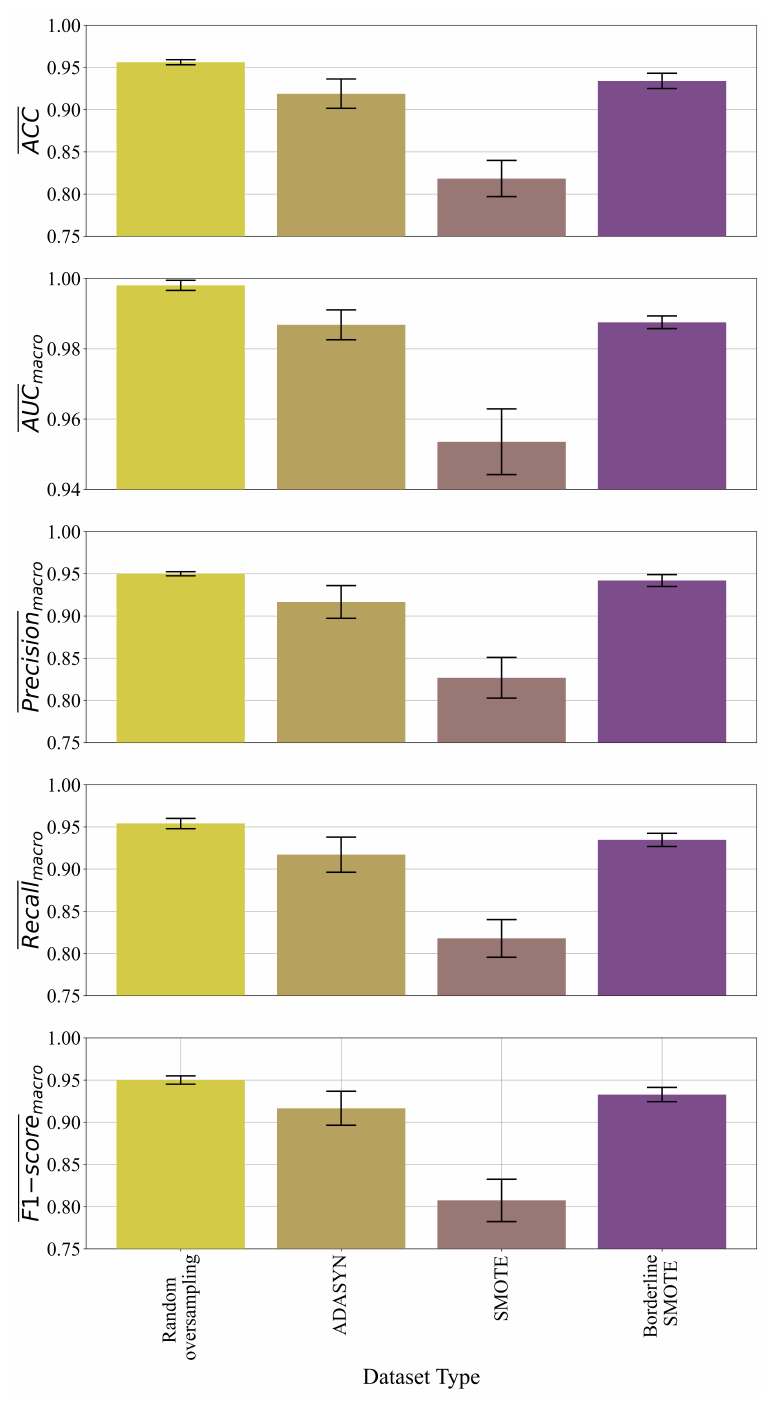
Figure 11. The graphical representation of mean values of ACC, AUC, precision, recall, F1-Score with standard